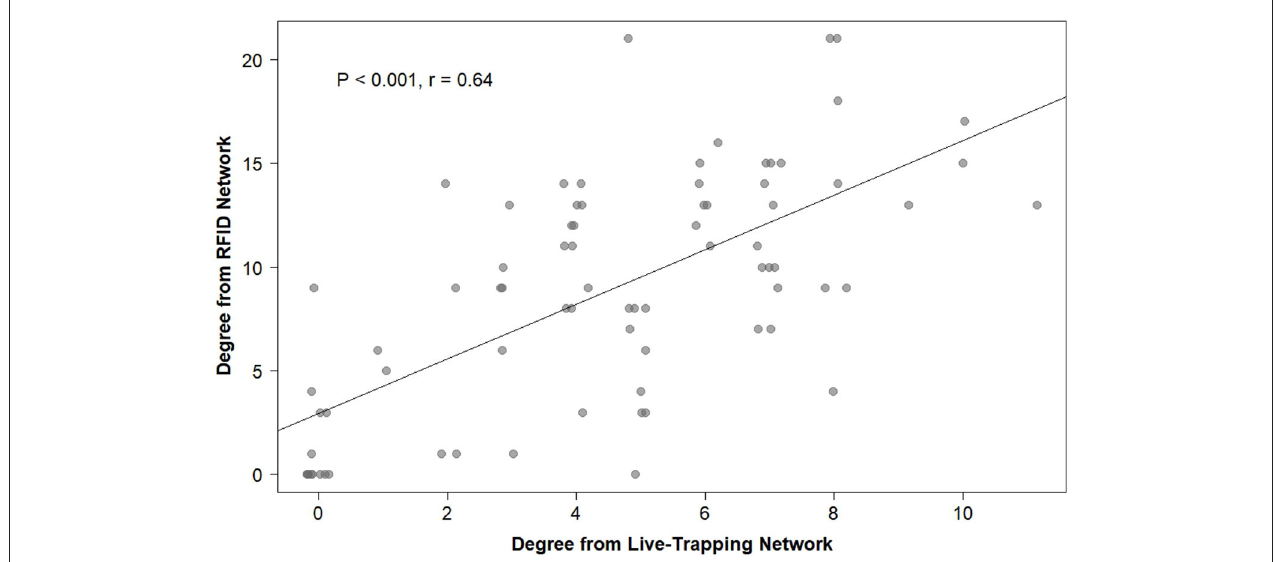
FIGURE 6 | The relationship between each individual prairie vole’s unweighted degree (the number of unique conspecifics each individual is connected to in either social network) generated from the social network using the live-trapping data and the unweighted degree generated from the social network using the automated RFID tracking